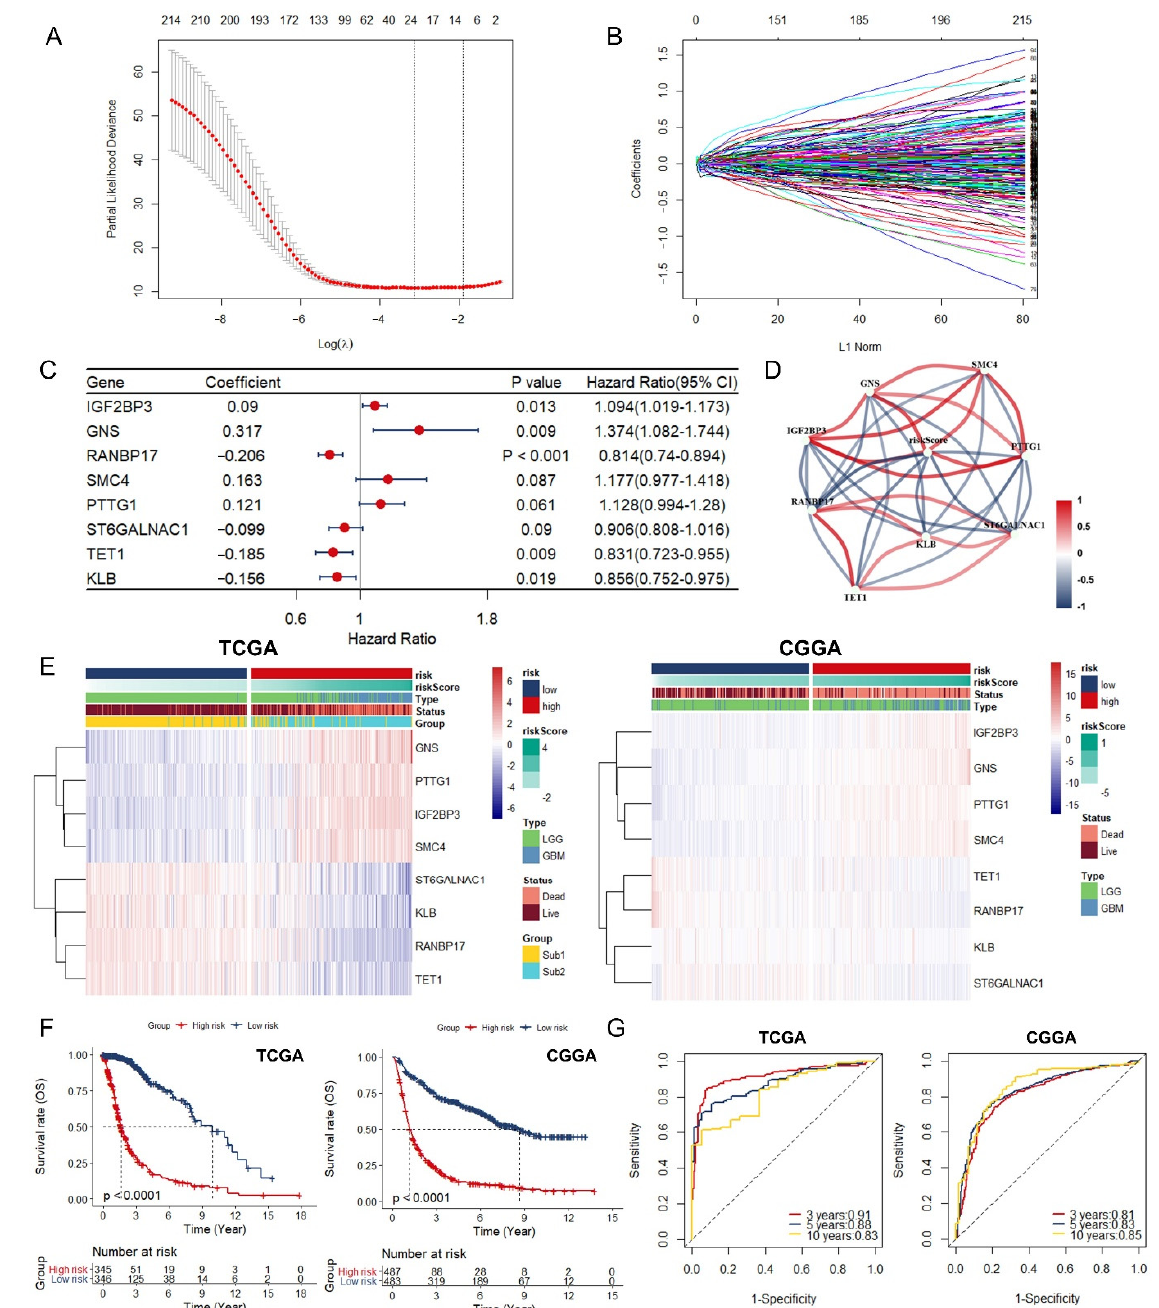
Figure 4. Identification and assessment of an immune-associated RBPs prognostic signature for overall survival in glioma: ( A ) Robust prognostic genes identified through LASSO regression algorithm. ( B ) Distribution of LASSO coefficients for 216 genes in the 10-fold cross validation. ( C ) Forest plot of the prognostic ability of the eight immune-related RBPs included in the prognostic signature. ( D ) A correlation network involving the eight immune-associated RBPs and risk score in TCGA. ( E ) Heatmap and clinicopathologic features of high- and low-risk groups based on the eight immune-associated RBPs in the TCGA (left, high risk = 345, low risk = 346) and CGGA (right, high risk = 487, low risk = 483) database. ( F ) Kaplan–Meier curves showing different overall survival of patients in low- and high-risk groups. ( G ) ROC curves of immune-associated RBPs for predicting the 3/5/10-year overall survival in TCGA ( left ) and CGGA ( right ) database. Based on the median of risk score, the glioma patients whose risk scores were higher than the median were defined as high-risk group and low-risk group was defined in a similar way in TCGA and CGGA database, respectively (Figure 4E). High expression of